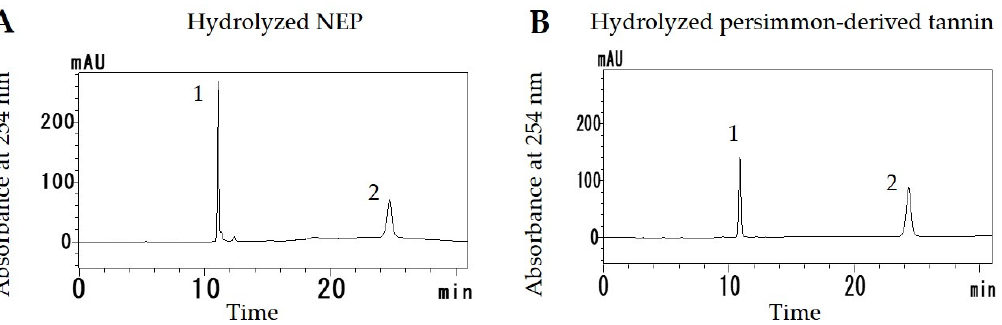
Figure 1. HPLC chromatograms of hydrolyzed non-extractable fraction of dried persimmon (NEP) ( A ) and persimmon-derived tannin ( B ).